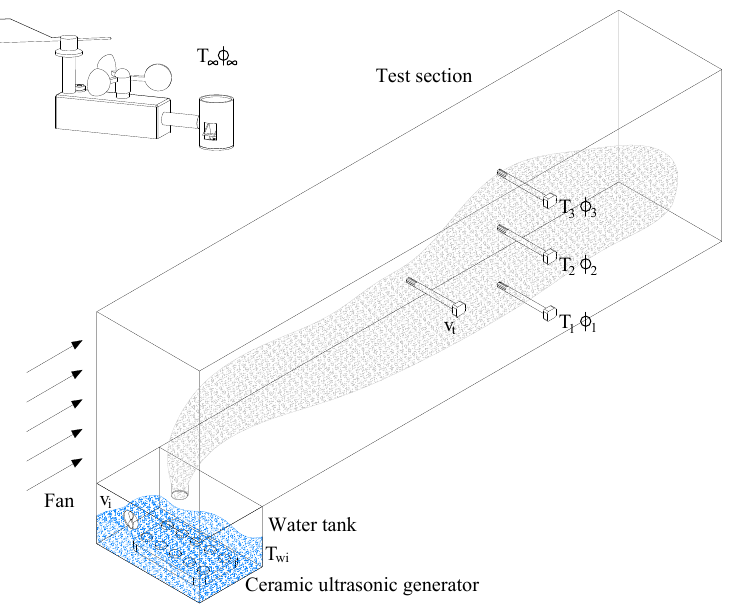
Figure 3. Schematic arrangement of the test section, mist generator and measurement